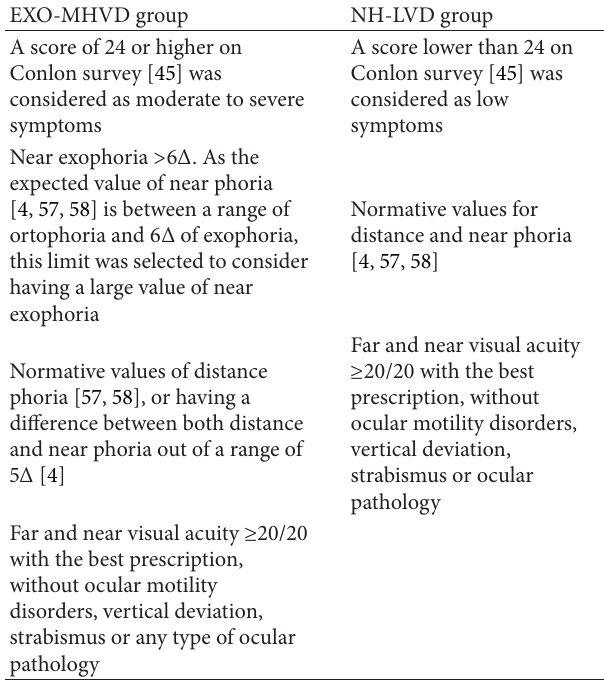
Table 1: Inclusion criteria for EXO-MHVD and NH-LVD